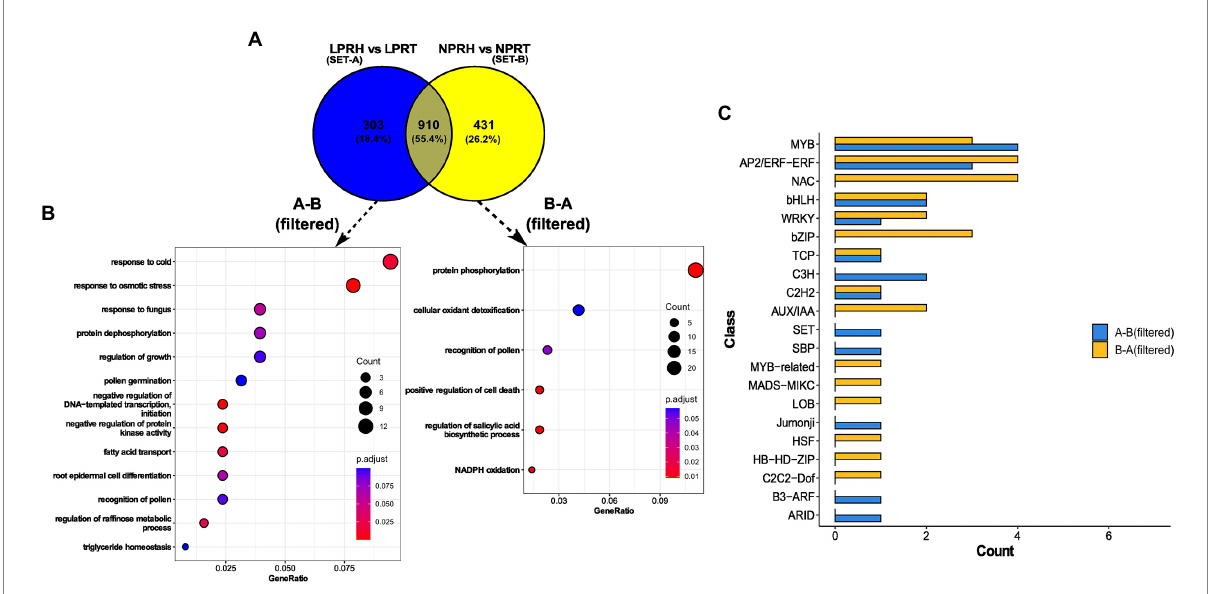
FIGURE 6 Preferentially expressed genes in root hairs (RH) specific to low phosphorus (LP) conditions. (A) Venn diagram comparing preferentially expressed genes in normal phosphorus (NP) (set A) and LP (set B) conditions. (B) Dot plot depicting enrichment of LP-specific (A-B, filtered) and NP-specific (B-A, filtered) genes. Here, the size of the dot represents gene count, and color depicts the adjusted value of p of enrichment. (C) Bar graph depicting the count of transcription factors (TFs) and regulators (TRs) in each class for LP (A-B, filtered) and NP (B-A, filtered) specific